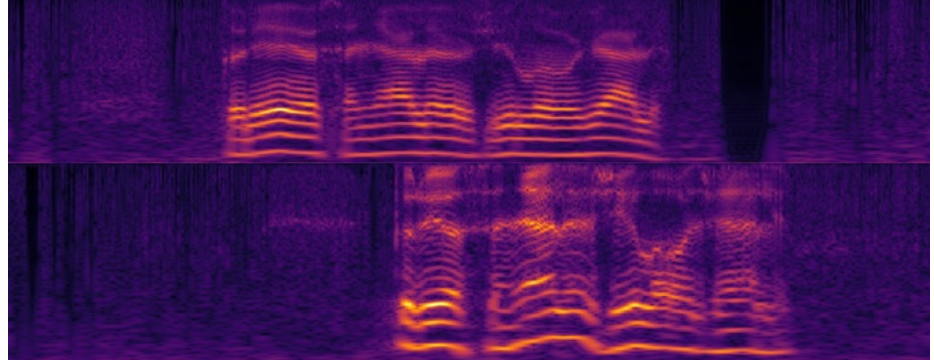
Figure 7. Cochleagrams of normal speech samples. Minimal frequency shifts and no aperiodicity or unintended phonatory breaks can be observed. Pauses between separate words are easily distinguishable.